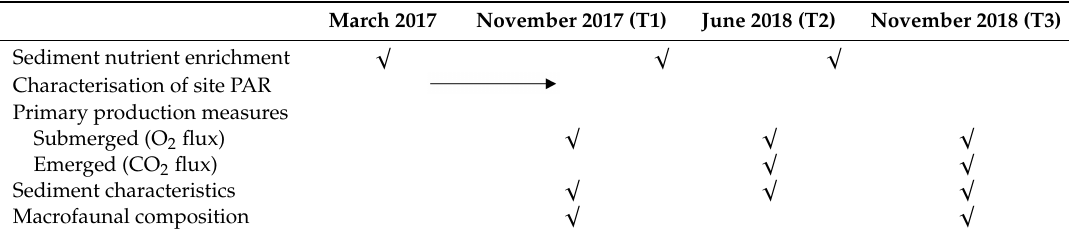
Table 1. Experiment timeline and parameters measured. T1 and T3 sampling includes all 6 sites, T2 sampling includes only 3 (TAU-O, TAU-T and